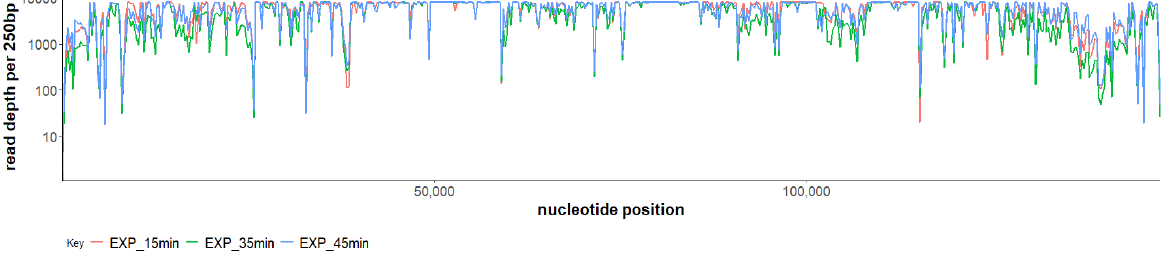
Figure 1. Transcription of Staphylococcus phage SAM1 genome during infection of Staphylococcus aureus at 15 min, 35 min, and 45 min using standard RNA-Seq.